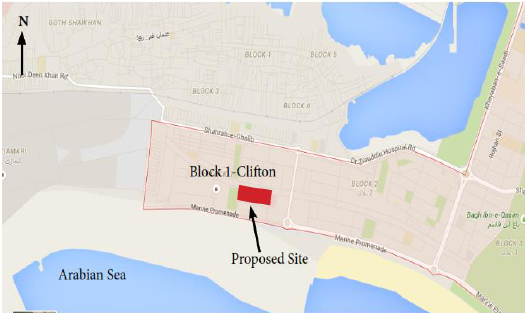
Fig. 3. Proposed site features, Karachi, Pakistan. Source: Google Maps, 2015.